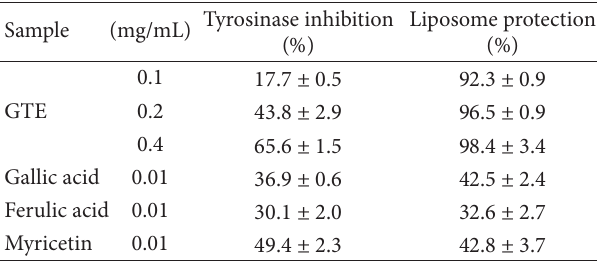
T 3: Effects of the aqueous extract of guava twigs (GTE) on tyrosinase inhibition and liposome